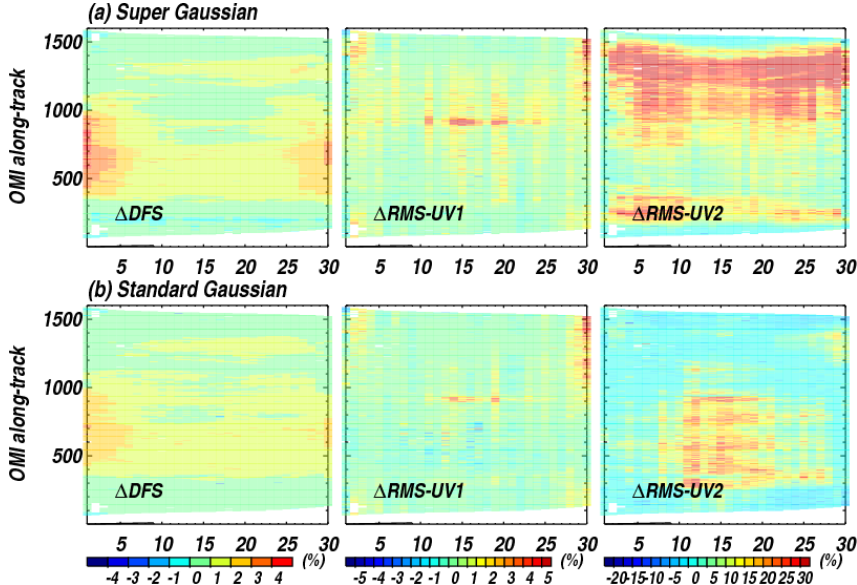
Figure 7. Same as Fig. 4, but for comparisons of the degrees of freedom for signal (DFS) and the root mean square (rms) of spectral fitting residuals in UV1 and UV2 with and without a zero-order pseudo absorber. Positive values indicate that both fitting residuals and DFSs are reduced due to the pseudo absorber.